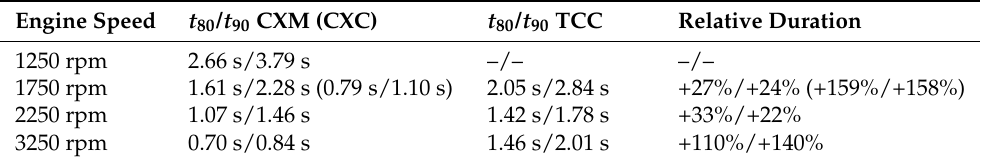
Table 6. Rise time until 80% and 90%, respectively, of the desired torque value is reached. As the load step with the Comprex is always faster, the “relative duration” quantifies the additional time the turbocharged engine requires. At an engine speed of 1750 rpm, this was also done with the Comprex and the conventional camshaft (CXC) for